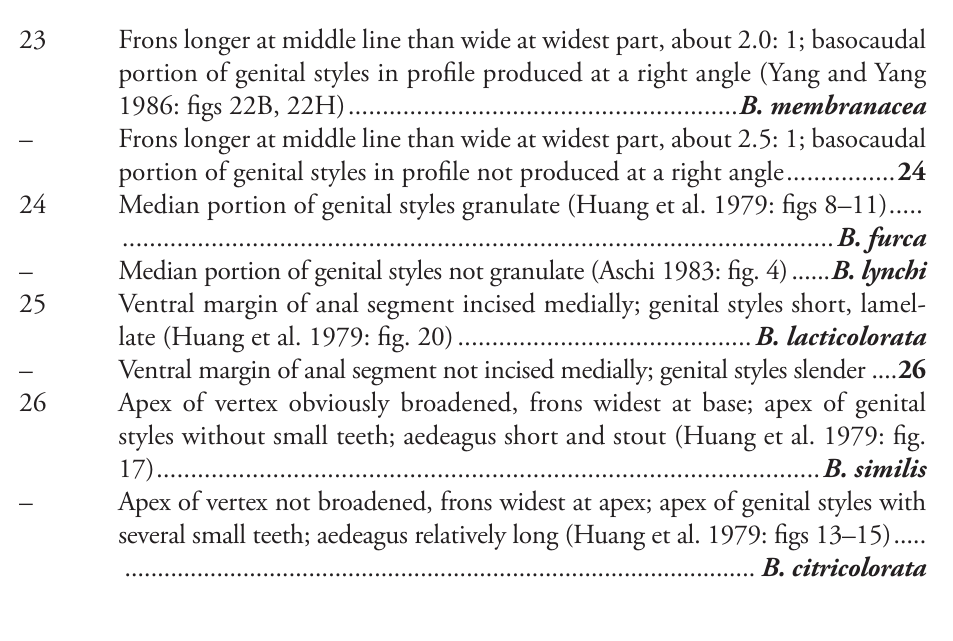
Type material. Holotype: ♂ , China: Yunnan Province, Yingjiang County (97°56'E, 24°41'N), on bamboo, 17 Aug. 2015, X.-S. Chen and L. Yang; paratypes, 5 ♂♂ , 23 ♀♀ , same data as